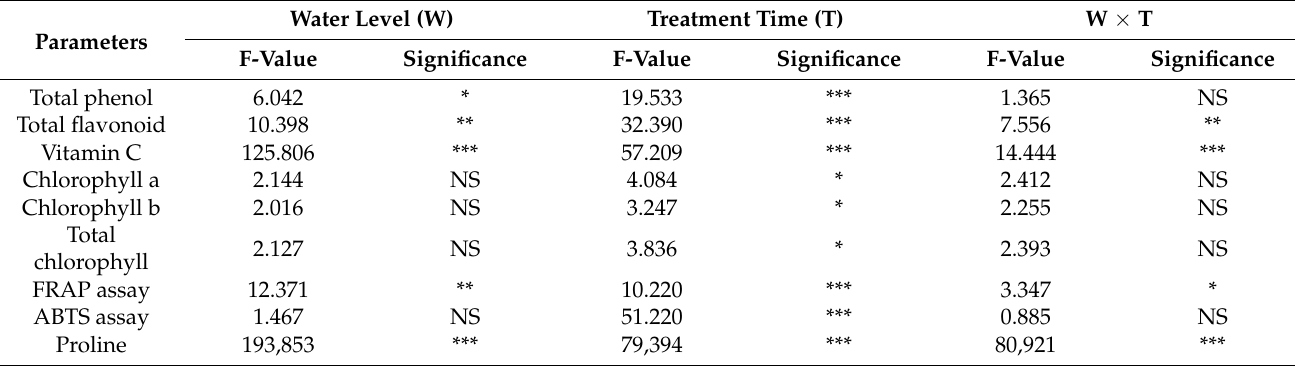
Table 2. Summary of analysis of variance for total phenol, total flavonoid, vitamin C, chlorophyll, proline, ferric reducing antioxidant power (FRAP) assay, and 2,2 (cid:48) -azino-bis(3-ethylbenzothiazoline-6-sulfonic acid) (ABTS) assay of lettuce seedlings at the two water levels and multiple treatment